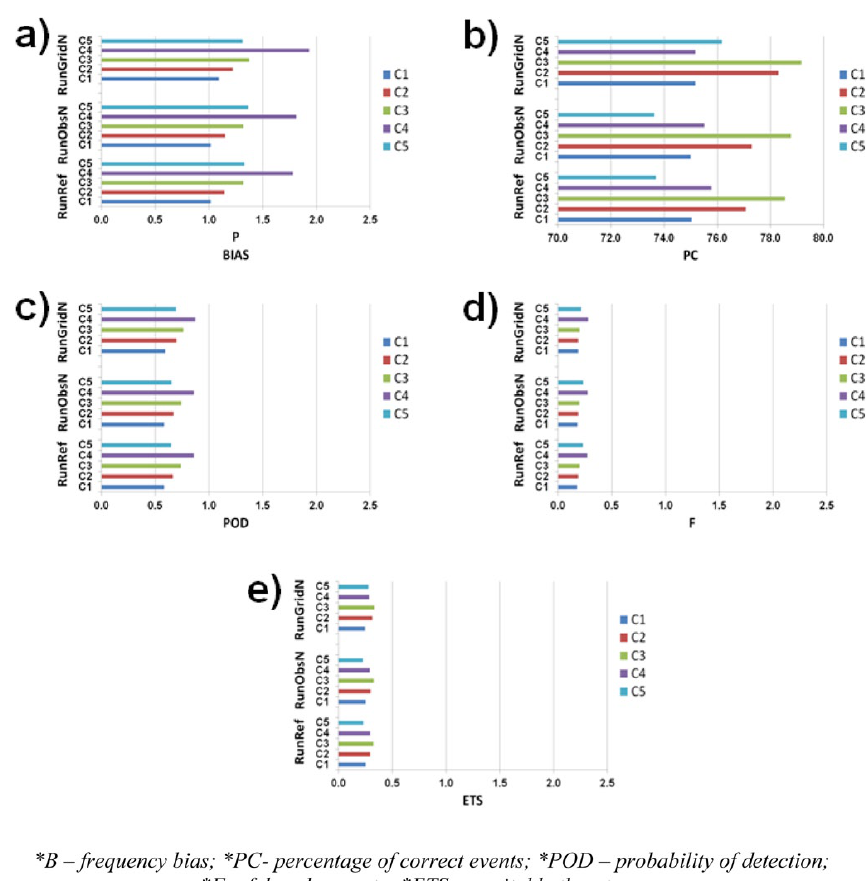
Fig. 9. Categorical verification measurements for hourly precipitation (above 0.1mmh − 1 ) for stations grouped by